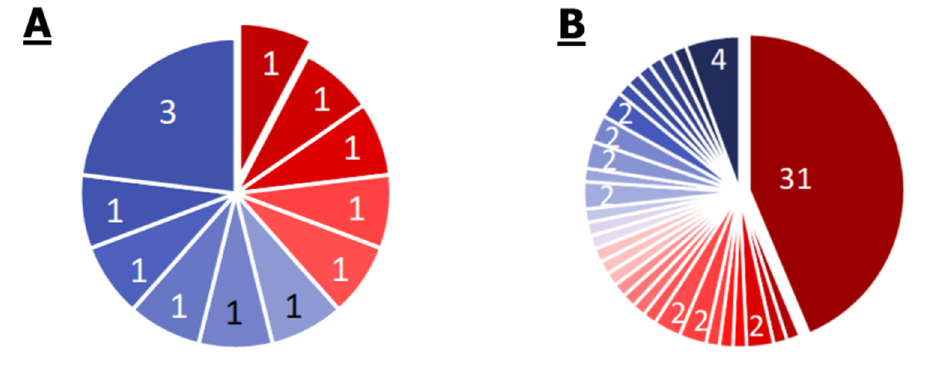
Figure 5. Pie chart of the proportion of annotations in the 92 genomes of Mycoplasma spp. strains. Numbers depict annotations with equal frequency. Frequency—from 0.01 to 1—is presented in the color of slices on the scale from blue to red for distribution of modules ( A ) and pathways ( B ). Small slices without numbers correspond to the sole annotation with such frequency. All the modules in the pangenome are metabolic and no modules of resistance are found. Distribution of pathway frequencies is remarkably dispersed. Only 42% of pathways are present in all genomes.